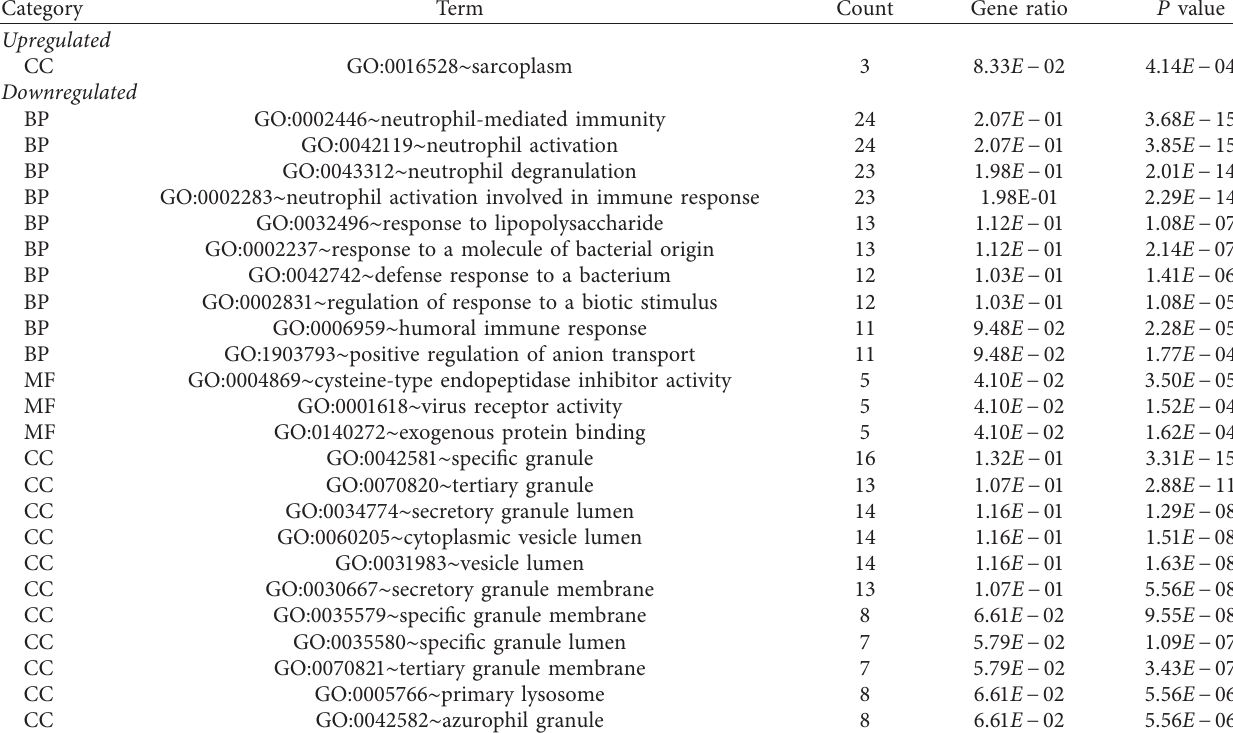
Table 3: Gene ontology analysis of common upregulated and downregulated